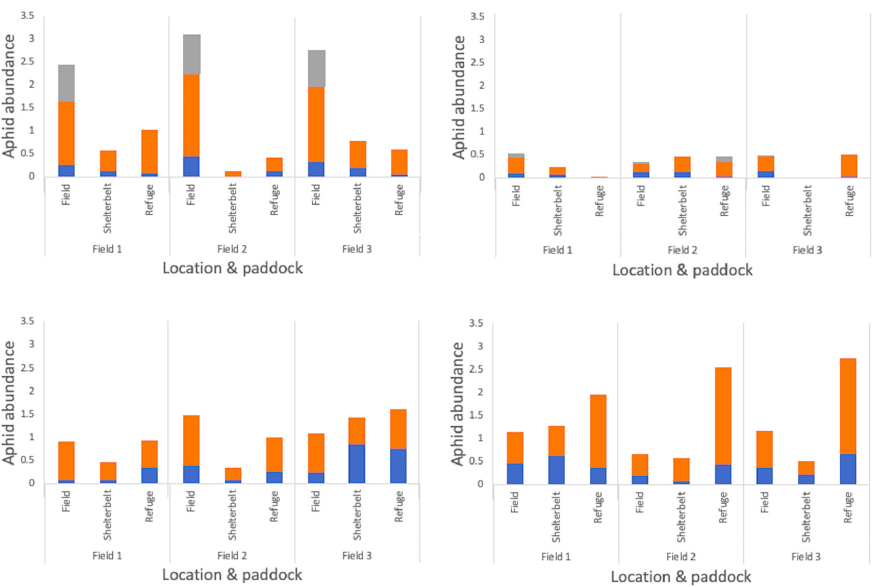
8 Figure 8. Logged numbers of aphid forms depending on location within and surrounding each crop in 2018 for those directly sampled for two minutes in ( a ) canola, and ( b ) wheat, and vacuum sampled for one minute in ( c ) canola, and ( d )